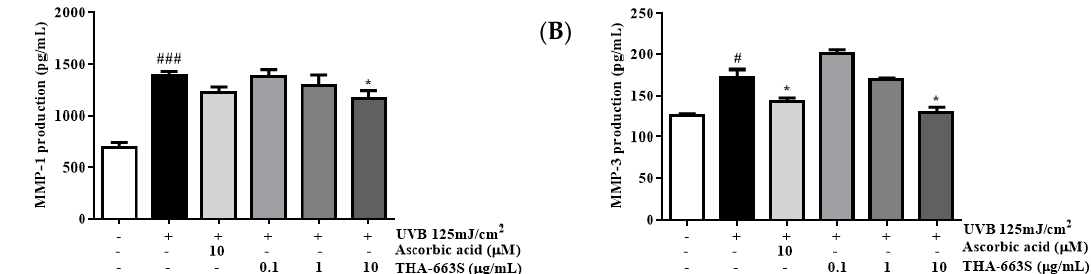
Figure 4. THA-663S inhibited the secretion of MMP-1 and MMP-3 in UVB-irradiated HaCaT cells. Following UVB irradiation (125 mJ/cm2), HaCaT cells were treated with or without the indicated concentration of THA-663S (0.1, 1, and 10 µg/mL) for 24 h. MMP-1 ( A ) and MMP-3 ( B ) levels were determined using ELISA kits. The results are shown as the mean ± SD of three independent experiments. # p < 0.05, ### p < 0.001 compared with non-irradiated group, * p < 0.05 compared with only UVB-irradiated group.